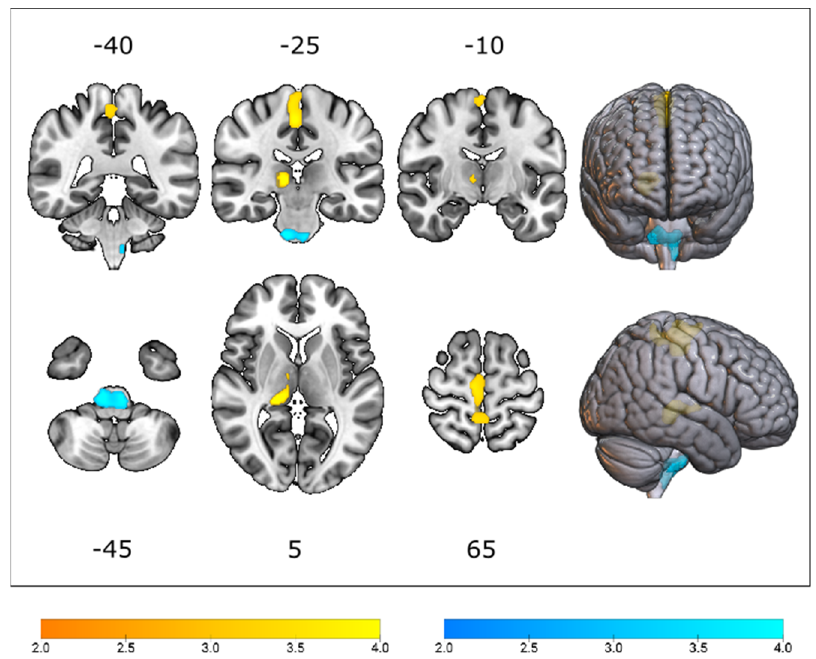
Figure 3. T-statistical map detailing patterns of relative hypometabolism (yellow) and hypermetabolism (blue) in C9orf72 -ALS, when compared to a group of matched sporadic ALS patients, thresholded at p uncorr < 0.001 at voxel level, and p FWE < 0.05 at cluster level. Clusters are overlaid on a T1-weighted template.